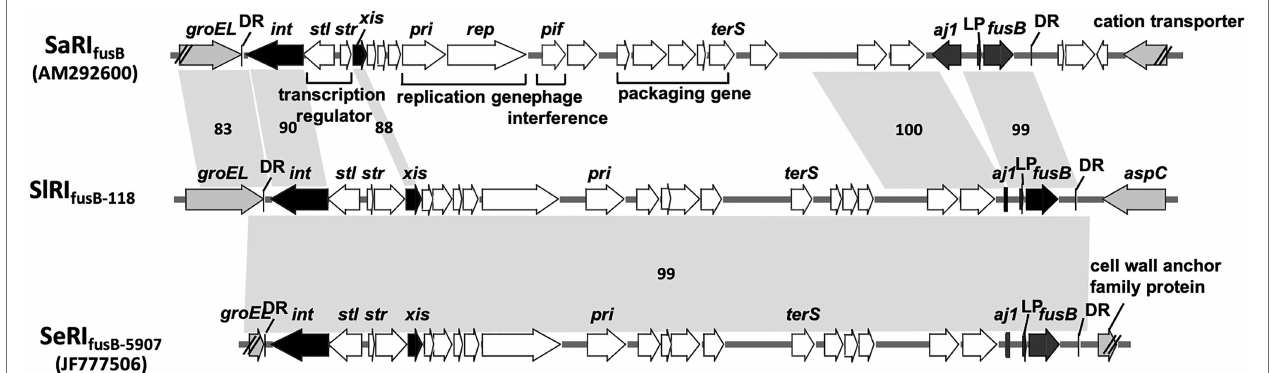
FIGURE 2 | Comparison of fusB -resistant islands between CGMH-SL118 and the other species. Three of the fusB resistance island from Staphylococcus lugdunensis CGMH-SL118 (SlRI inserted below the groEL : the left side was varied by each strain. The dark color represents integrase ( int ), excisionase ( xis ), fusB core region genes ( aj1 and fusB ), and two sequences (LP; aj1 -leader peptide, and DR; direct repeat sequence). The other genes were labeled with white color. Critical genes are additionally labeled with the abbreviation; stl and str are transcription regulators; pri and rep are responsible for replication; pif is response for phage interference; terS is phage terminase small subunit, which is responsible for phage packaging. The number accompanied with shadow connected to each fusB resistance island represents the sequence